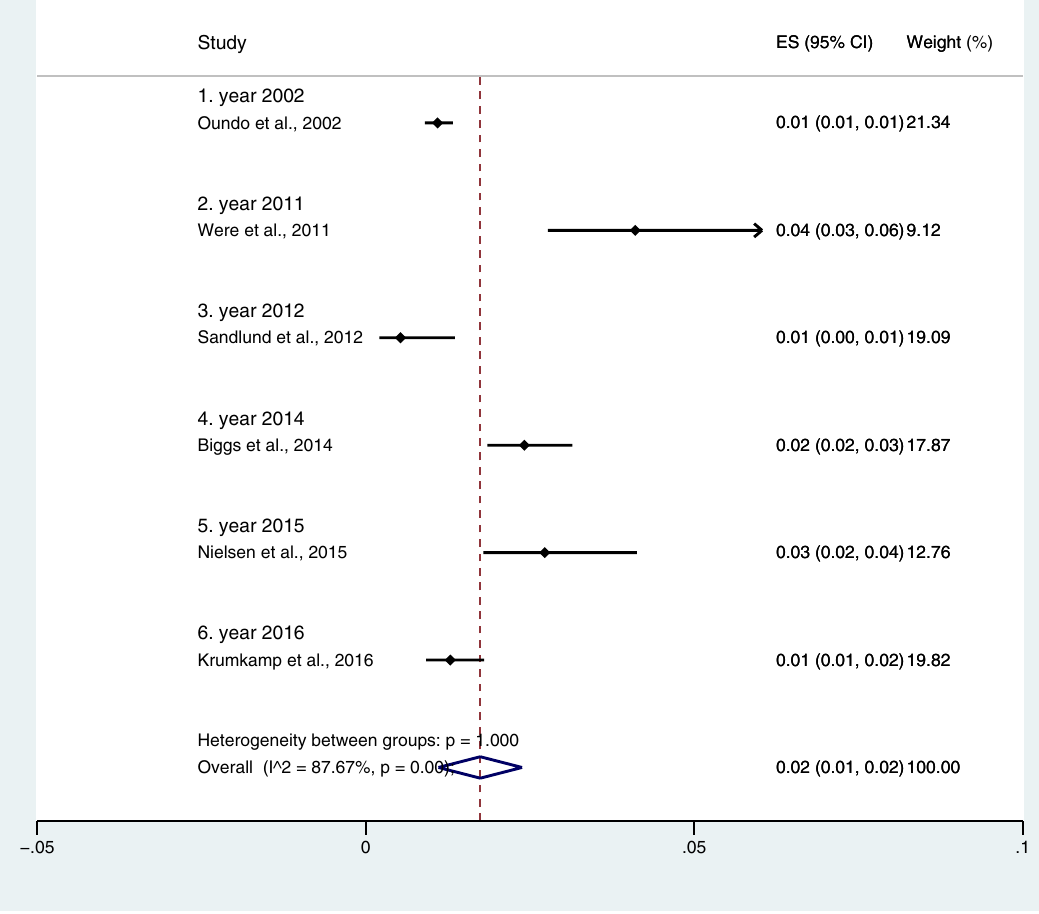
Figure 20. Prevalence of NTS infection among patients with malaria using blood cultures for the identification of Salmonella spp. infection stratified by time (publication years). ES proportion estimate (multiply 100 units for interpreted as prevalence estimate), CI confidence interval, NS not